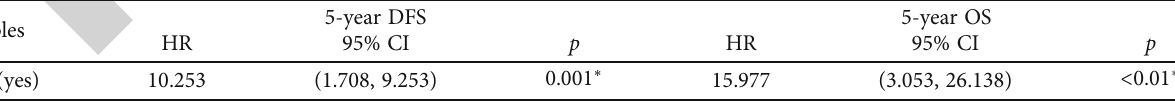
Table 6: Multivariable analyses for DFS and